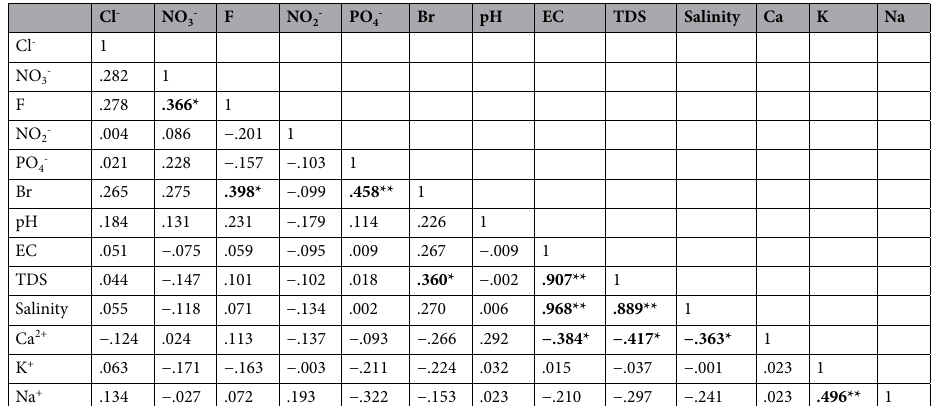
Table 5. Pearson correlation matrix among the variables. Signifance values are in bold. *Correlation is significant at the 0.05 level (2-tailed). **Correlation is significant at the 0.01 level